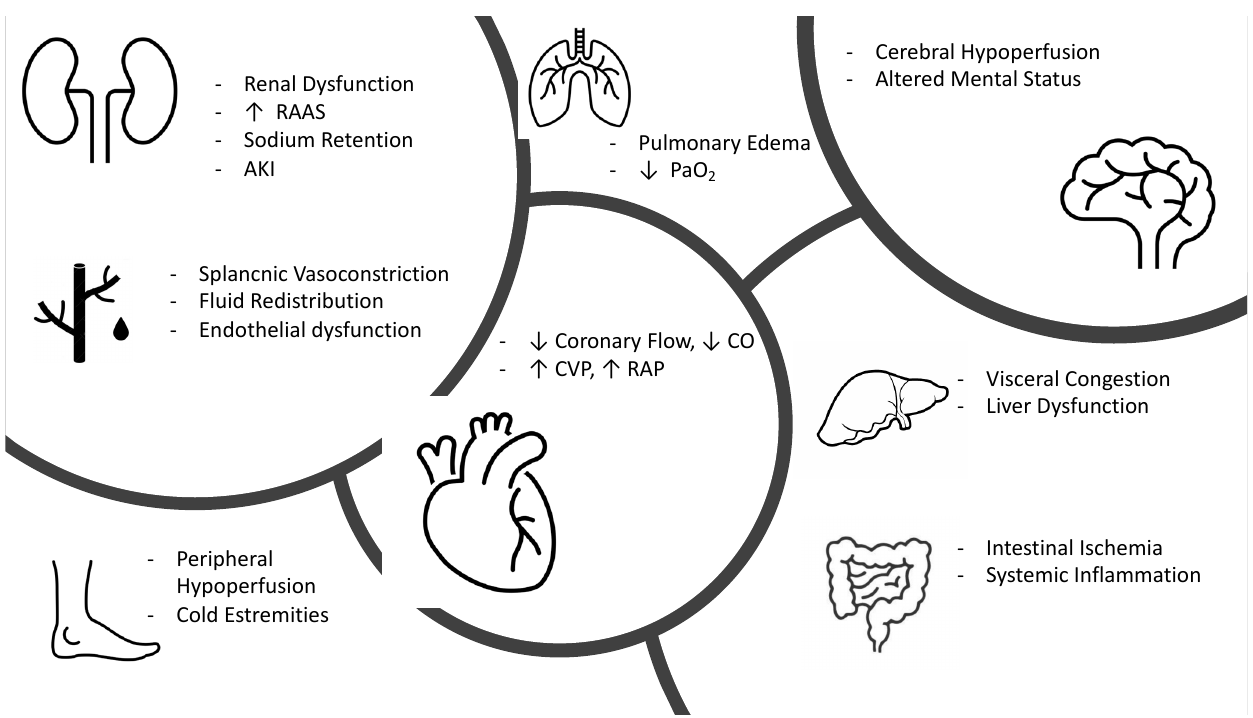
Figure 2. Pathophysiology of hypoperfused AHF. RAAS, renin angiotensin aldosterone system; AKI, acute kidney injury; CO, cardiac output; CVP, central venous pressure; RAP, right atrial pressure.